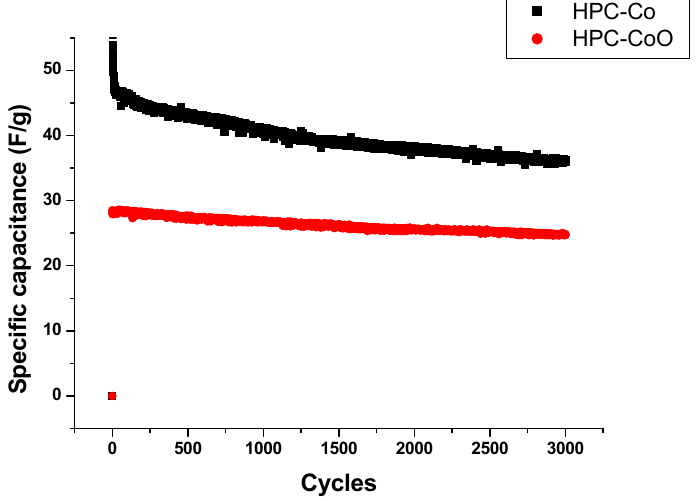
Figure 17. Long-term cycling of HPC-Co (1) and HPC-CoO (2) electrodes for 3000 cycles. Long-term recycling of (1) and (2) electrodes shows minor obvious fade with a small decrease of ~6%, and 9% respectively, in the specific capacitance value after 500 cycles. The decrease in the case of 3000 cycles experiment was 23.4% and 12.1%